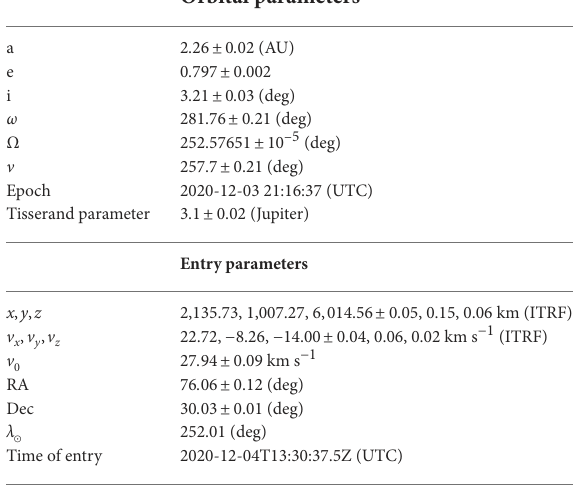
TABLE 1 Orbital parameters. Note that the orbital parameters with zenithal attraction removed are using an epoch 16.23 h before atmospheric entry. The radiant is reported as the apparent radiant, without removal of Earth’s gravitational